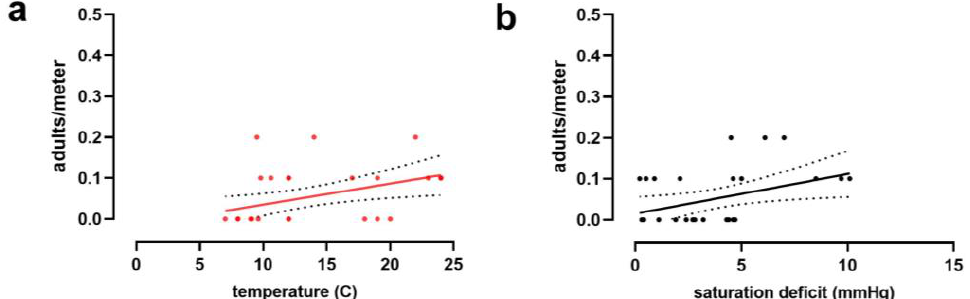
Figure 5. Representation of the linear regression equations between the environmental variables registered, temperature ( a ) and saturation deficit ( b ), and the relative abundance of Ixodes scapularis activity peaks of adults.